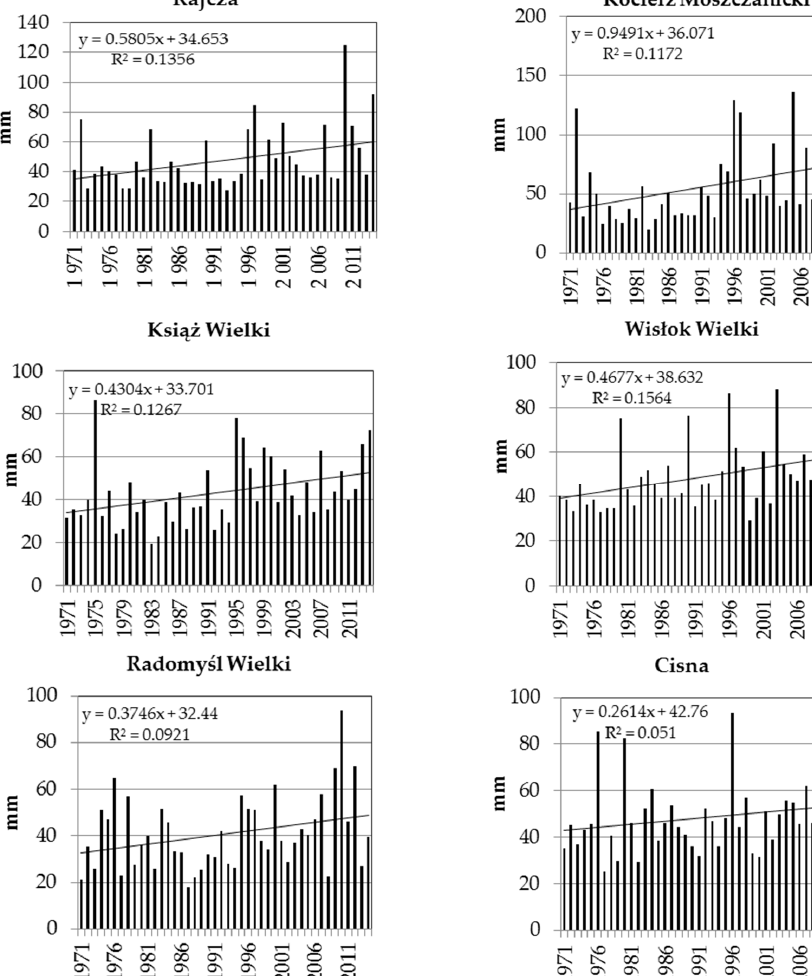
Figure 2. The annual maximum daily precipitation and significant trend at 0.05